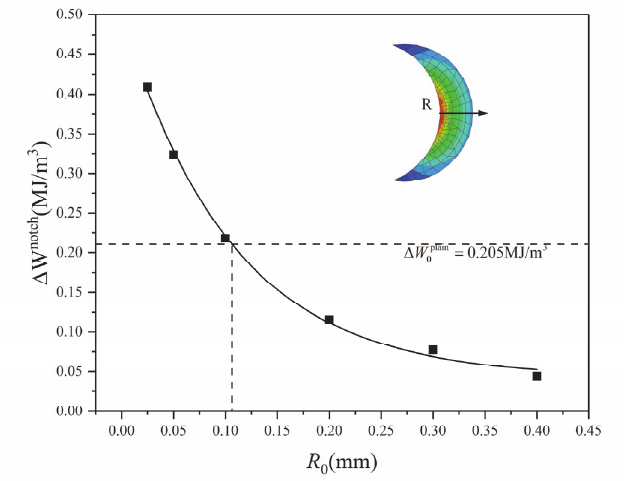
Figure 5 : Numerical values of notch W  as a function of the critical radius R 0